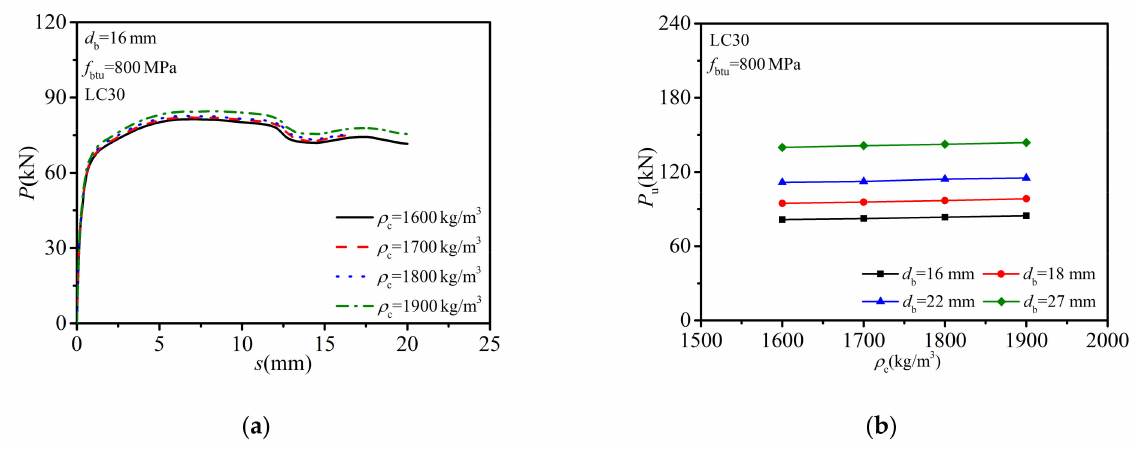
Figure 15. Influence of concrete density ( ρ c ): ( a ) force-slip relationship; ( b ) shear capacity.